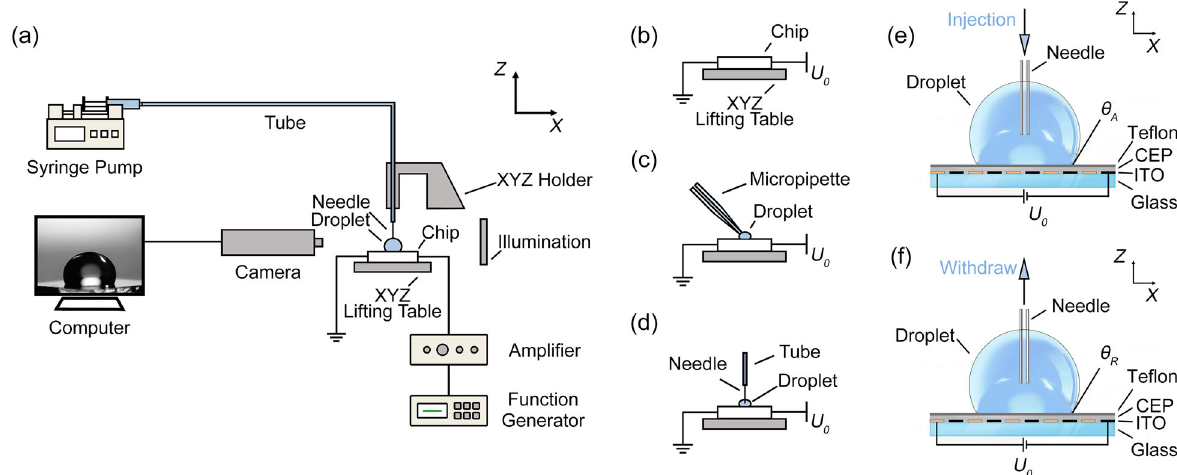
Fig. 5 Experimental set-up and measurement process. a Experimental set-up. b – f Apparent contact angle hysteresis measurement process. b The electrowetting on dielectric (EWOD) chip is charged by applying voltage U 0 before adding a liquid sample, c droplet dispensing on the charged chip, d connection to the inlet tubing, e advancing contact angle ( θ A ) measurement by adding liquid at constant voltage until the onset of contact line motion, f receding contact angle ( θ R ) measurement by removing liquid at constant voltage. Abbreviations: ITO, indium tin oxide; CEP, cyanoethyl pullulan; XYZ, 3-axes translation